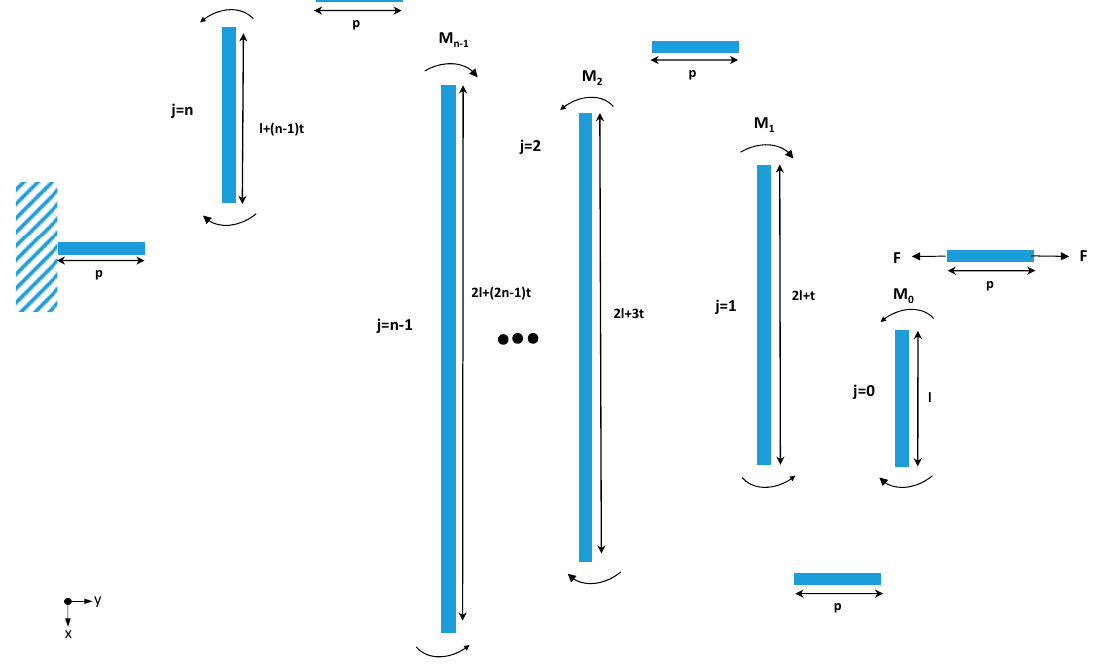
Figure 2. Free body diagram of the ASSM.